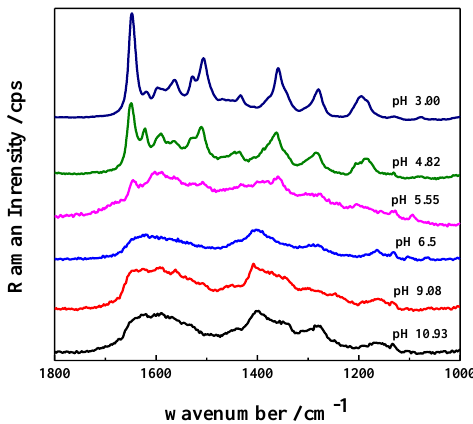
Figure 5. Raman responses of the substrate β-CD-Ag/PVA after being soaked in water at different pH values.